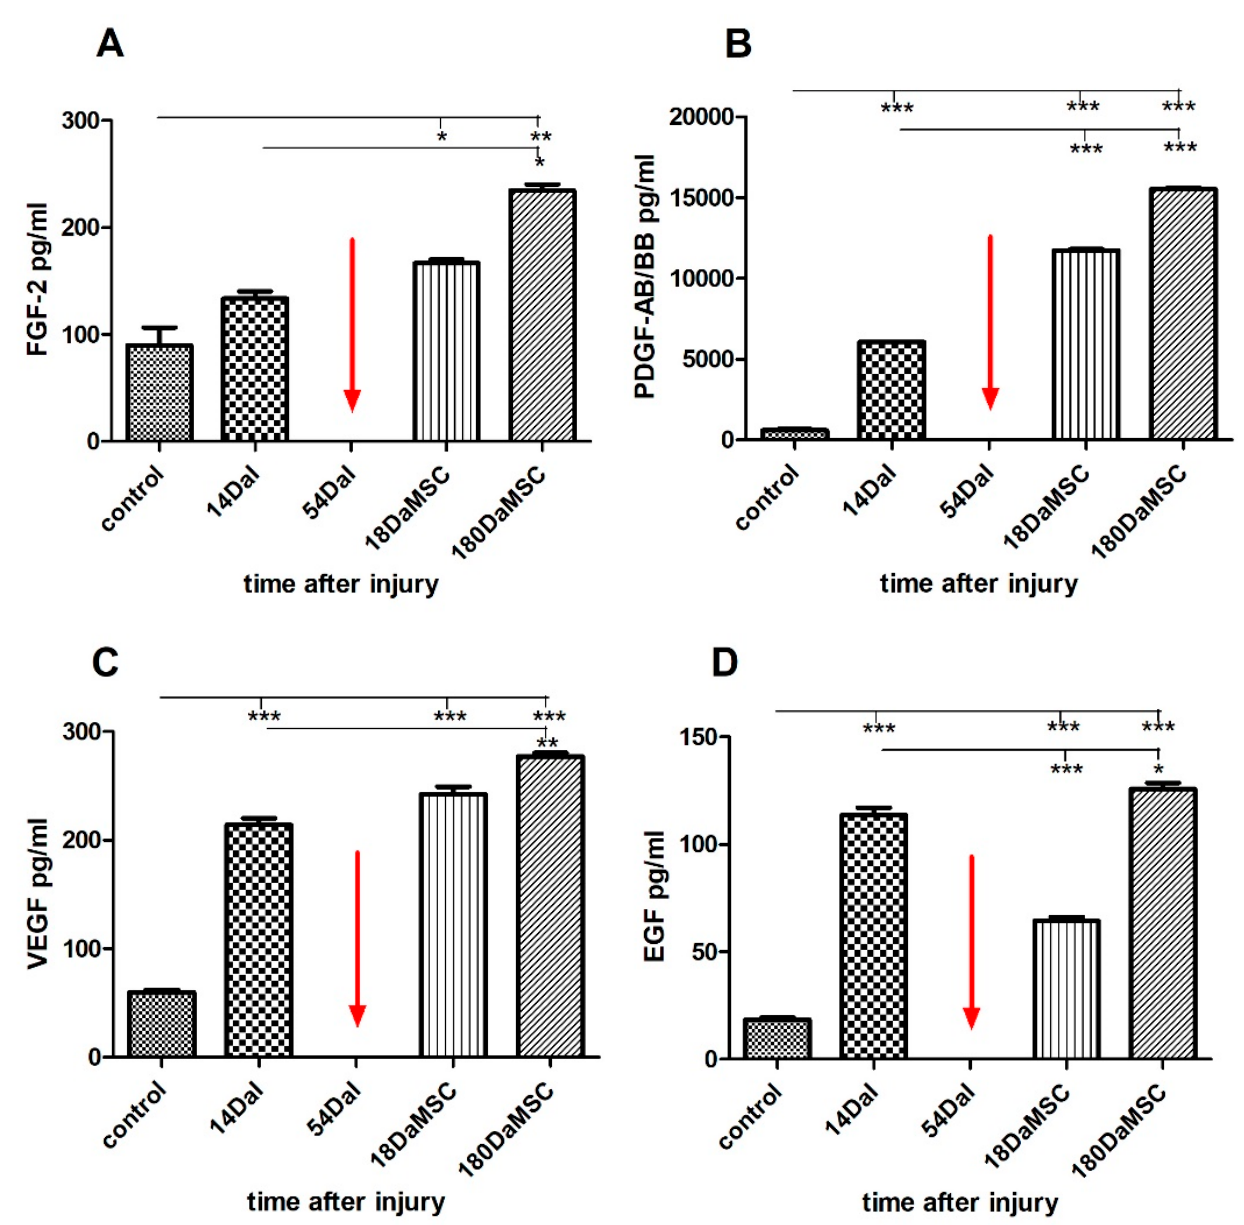
Figure 7. An overview of the level of the growth factors in the serum of an SCI patient treated with autologous BM-MSCs. Fourteen days after the injury, we recorded significantly higher levels of PDGF-AB/BB ( B ), VEGF ( C ), and EGF ( D ) in the patient’s serum when compared with control levels. FGF-2 protein levels also increased after SCI, but not significantly ( A ). BM-MSCs application showed a significant increase in FGF-2, PDGF-AB/BB, and VEGF levels. Conversely, there was a significant decrease in EGF protein expression after the application of autologous BM-MSCs at 18 DaMSC in comparison with its level before BM-MSCs treatment at 14 DaI ( D ). The red arrow indicates the administration time of autologous BM-MSCs. Data are shown as the mean ± SD, * p < 0.05, ** p < 0.01, *** p < 0.001. DaI—Days after Injury, DaMSC—Days after BM-MSCs transplantation.